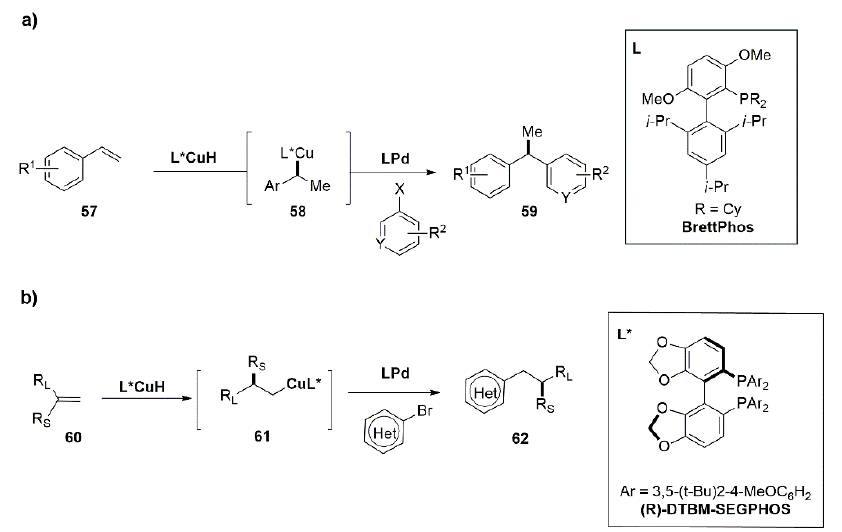
Figure 29 . Asymmetric hydroarylation by Cu/Pd cooperative catalysis for the synthesis of 1,1-diarylalkanes ( 59 ) ( a ) and for the synthesis of arenes with β -stereogenic center ( 62 ) ( b ).